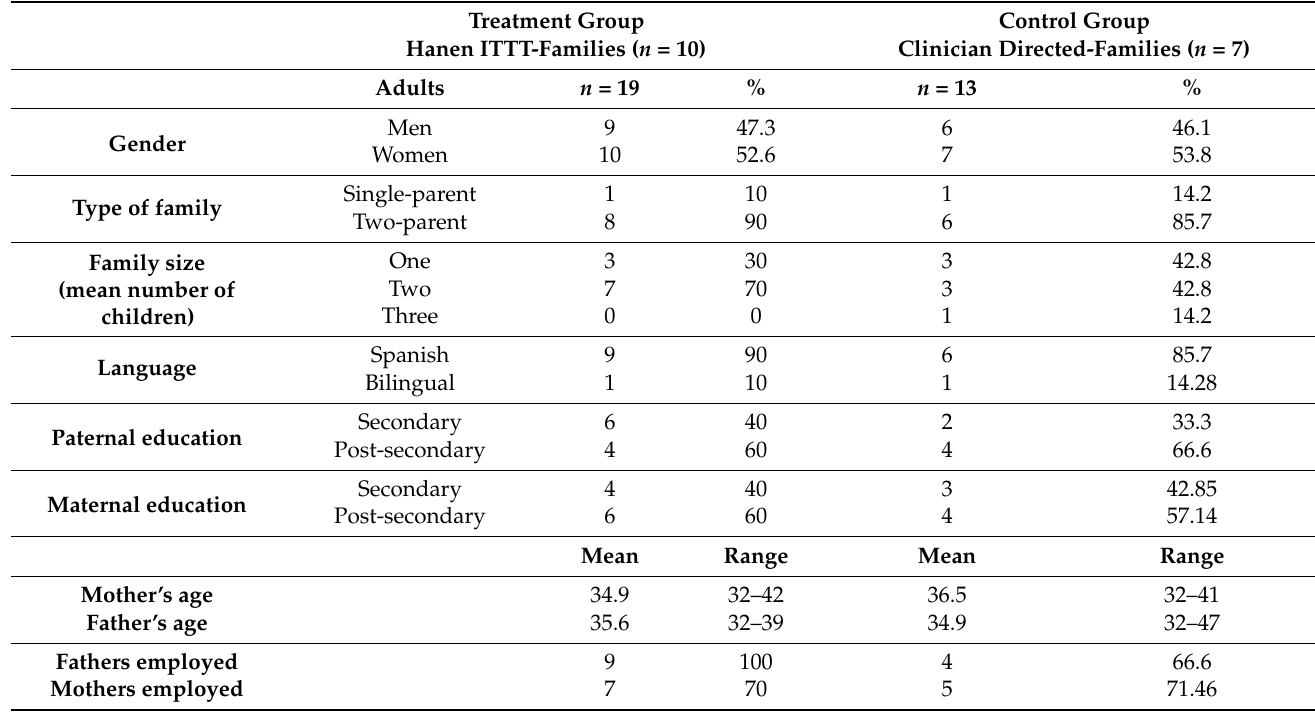
Table 1. Sociodemographic characteristics of the families.